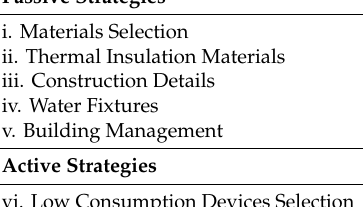
Table IV. Detailed